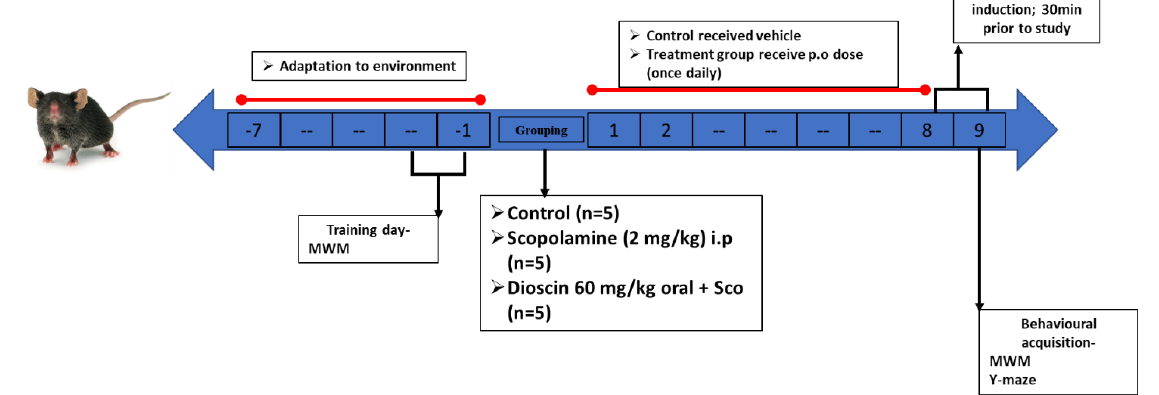
Figure 7. Schematic presentation of scheduling for animal grouping, treatment, behaviour, and sac-